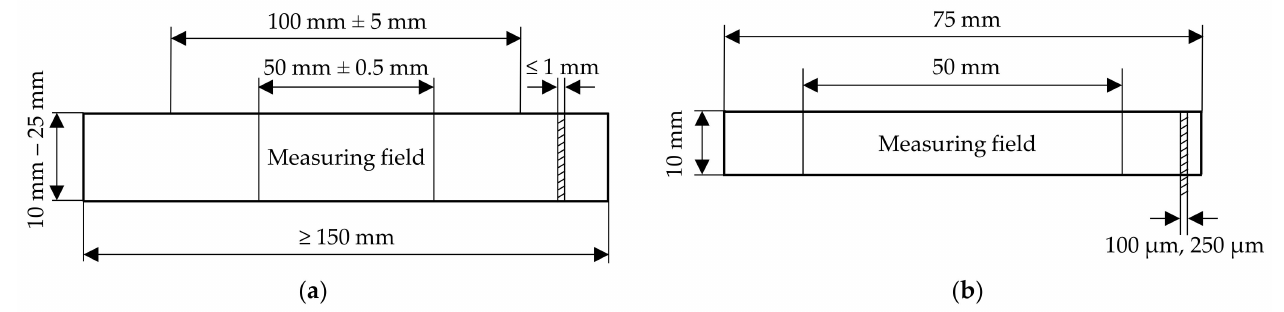
Figure 2. ( a ) Dimensions of a rectangular strip specimen according to [24] and ( b ) dimensions of the used strip